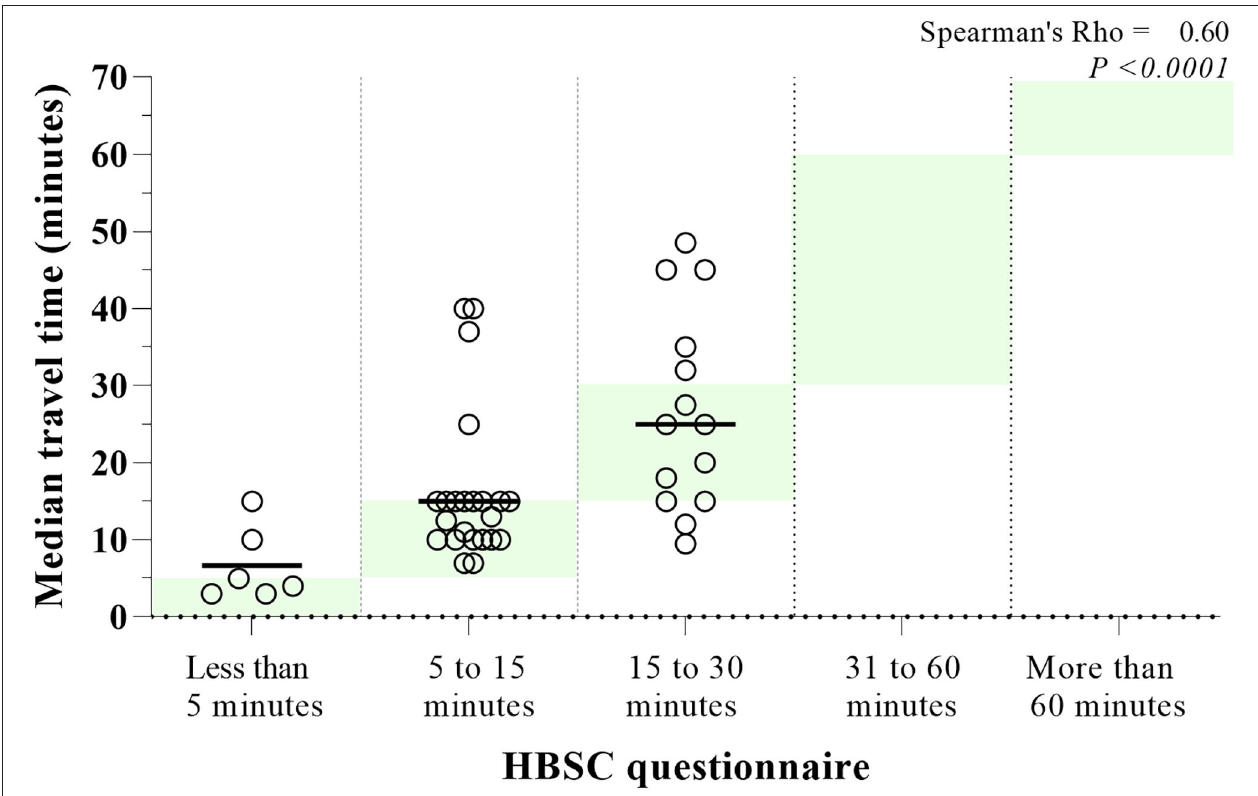
FIGURE 3 | Typical travel duration (median) to school logged in travel diaries (dot) categorized by each participants response from the HBSC questionnaire. Green shadow background indicates the categorize from HBSC in the graph. Vertical line = median in each questionnaire